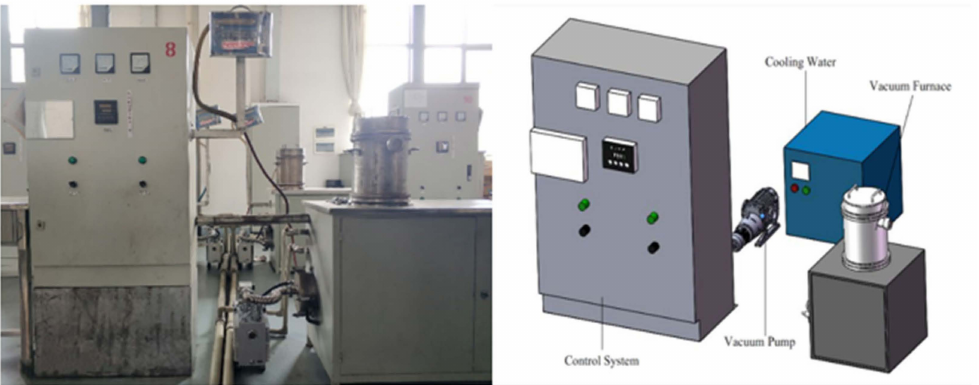
Figure 5. Photograph and schematic diagram of vacuum system